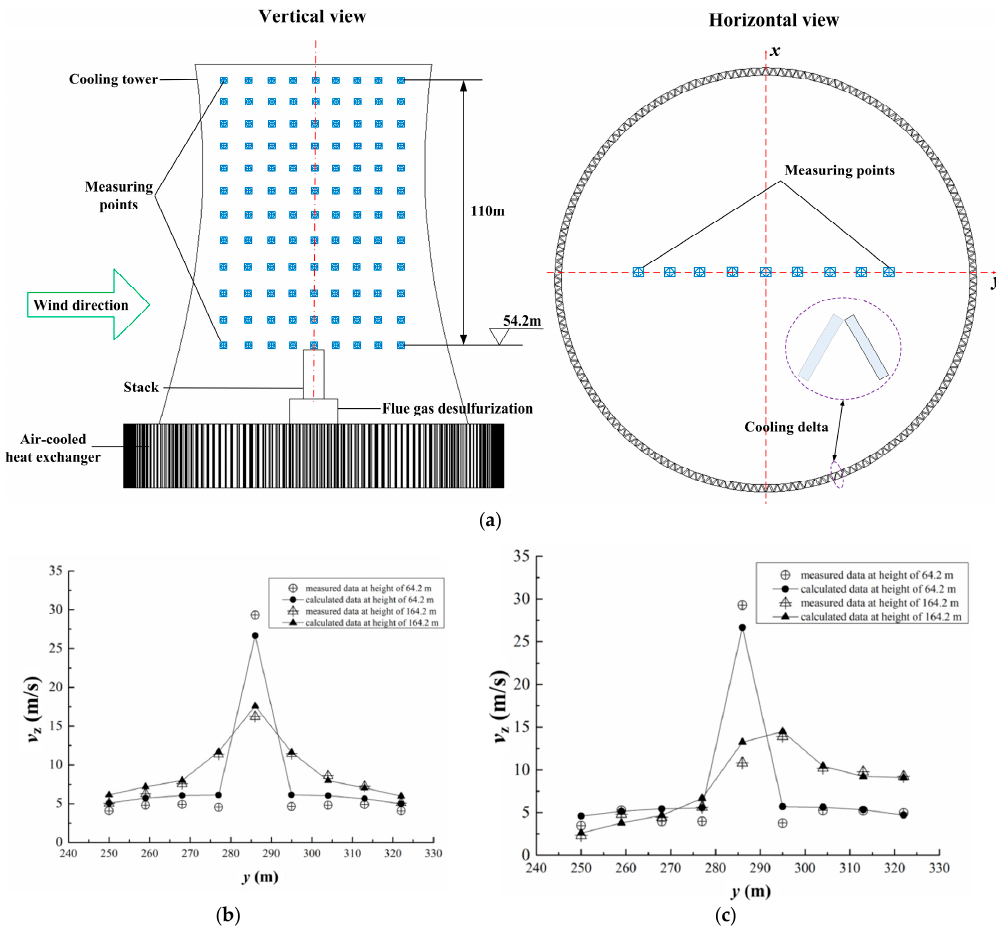
Figure 7. Experimental validation for numerical simulation. ( a ) Measuring points in vertical and horizontal views; ( b ) Ascending velocity without winds; ( c ) Ascending velocity at 4 m/s.